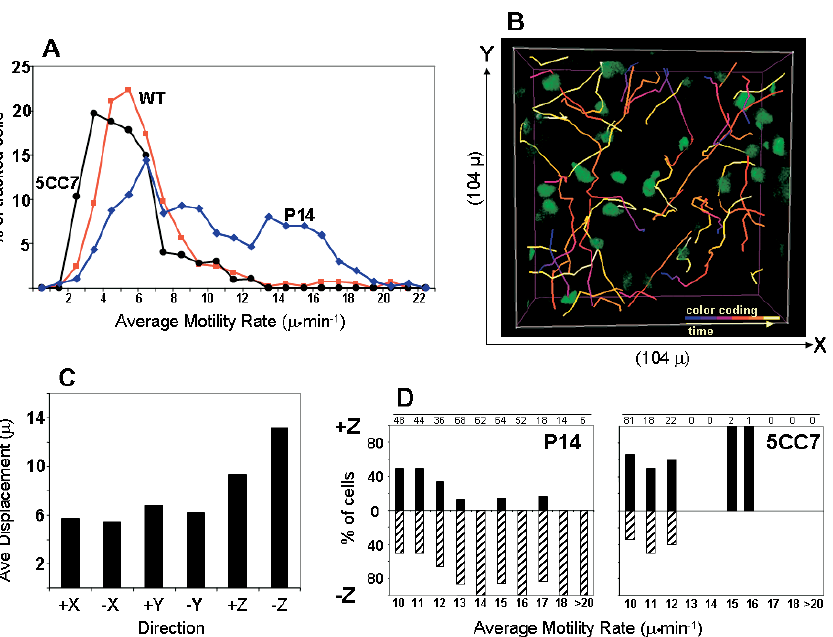
Figure 4. Positive Selection Leads to an Increased Frequency of MR hi Thymocytes Migrating away from the Thymic Capsule (A) A histogram showing the frequency distribution of average motility rates for positively selecting (blue, P14) and nonselecting (black, 5CC7) transgenic thymocytes compiled from over 1,200 P14 and 875 5CC7 thymocytes from, respectively, four and three independently imaged thymic lobes. Data (from Figure 2A) from wild-type (WT) thymocytes (red) were overlaid for comparison. P14 cells moving at motility rates greater than 13 l m/min were 34% of total imaged thymocytes (Videos S6 and S7) compared to approximately 1% of wild-type cortical thymocytes. Analysis of 5CC7 thymocytes showed nearly complete absence of cells moving at motility rates greater than 13 l m/min, a value that differed significantly ( p = 0.002) from wild-type cortical thymocytes. (Video S8) (B) Image showing trajectories of representative P14 MR hi cells. Note tracks for P14 thymocytes are relatively linear compared to the tracks of wild-type thymocytes (see Figure 1). (C) Bar graph showing the average displacement per cell moved in each direction over a 3-min time interval (left). Data was computed from more than 100 P14 MR hi cortical thymocytes compiled from four independent experiments. Data from individual runs are shown in Figure S5. (D) Results of step analysis on 412 P14 thymocytes as a function of motility rate are shown (left). Results of step analysis on 123 5CC7 thymocytes are shown for comparison (right). P14 cells moving at MR greater than 13 l m/min showed strong bias for movement in the (cid:1) z direction (away from capsule) whereas 5CC7 thymocytes showed random use of both þ z and (cid:1) z directions. DOI: